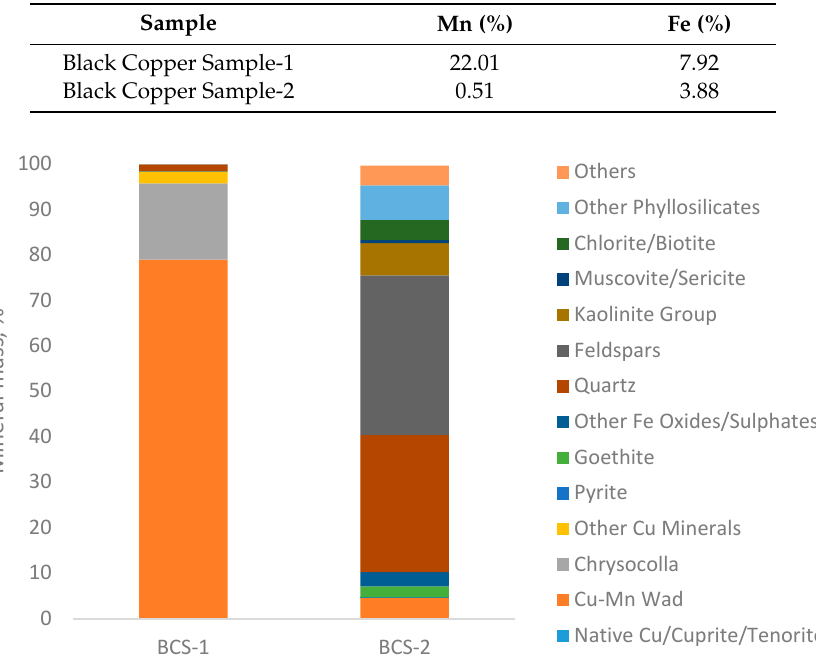
Table 1. Chemical composition of black oxide samples.